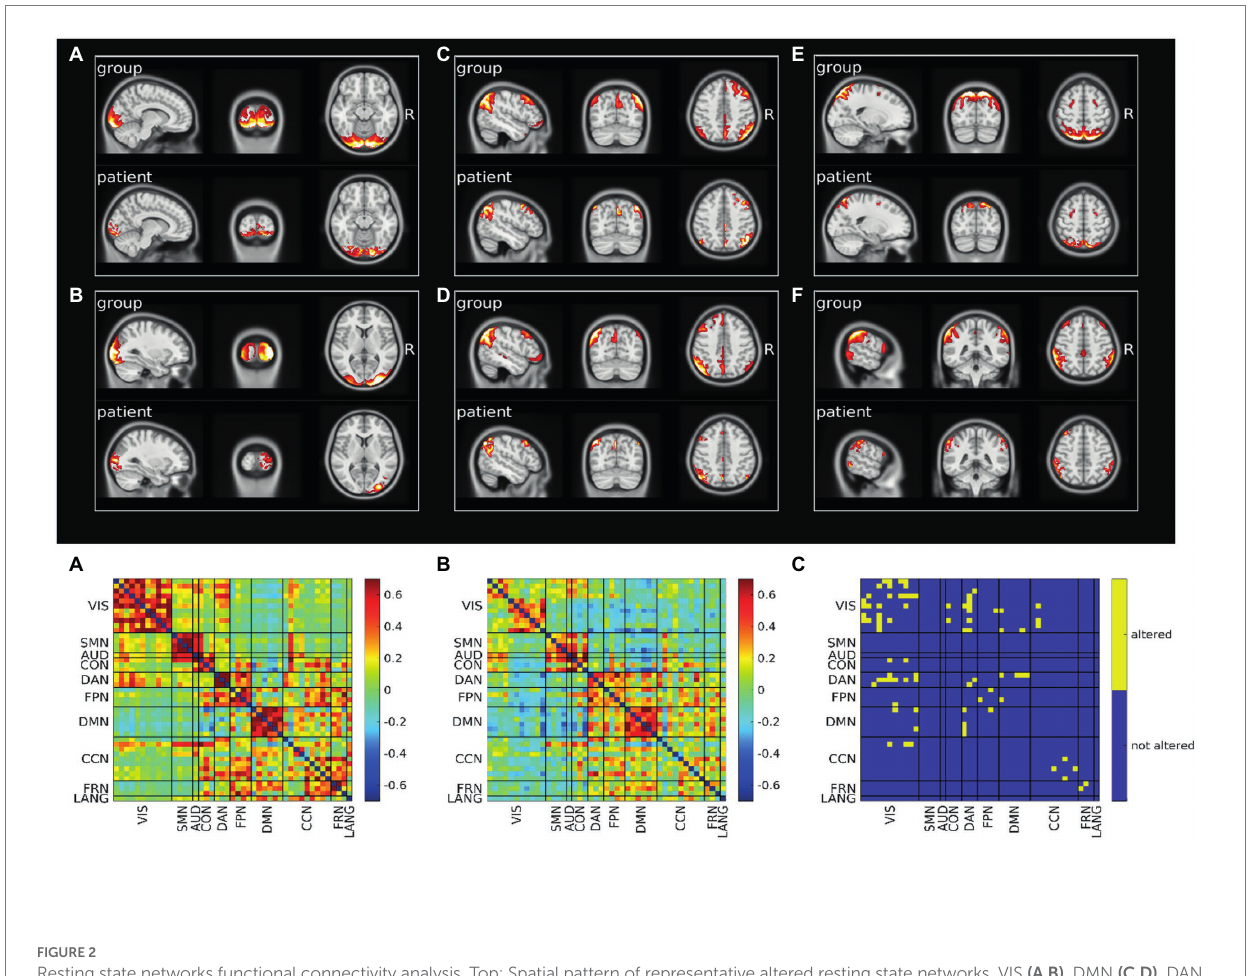
FIGURE 2 Resting state networks functional connectivity analysis. Top: Spatial pattern of representative altered resting state networks. VIS (A,B) , DMN (C,D) , DAN (E) , and FPN (F) . In each panel resting state network spatial pattern is reported for the group of healthy subjects and for the patient, respectively in the upper and lower part of the panel. Bottom: Functional connectivity between resting state networks. Average across the healthy group is shown in panel A , patient’s connectivity in panel B , and patient’s altered connections in panel C